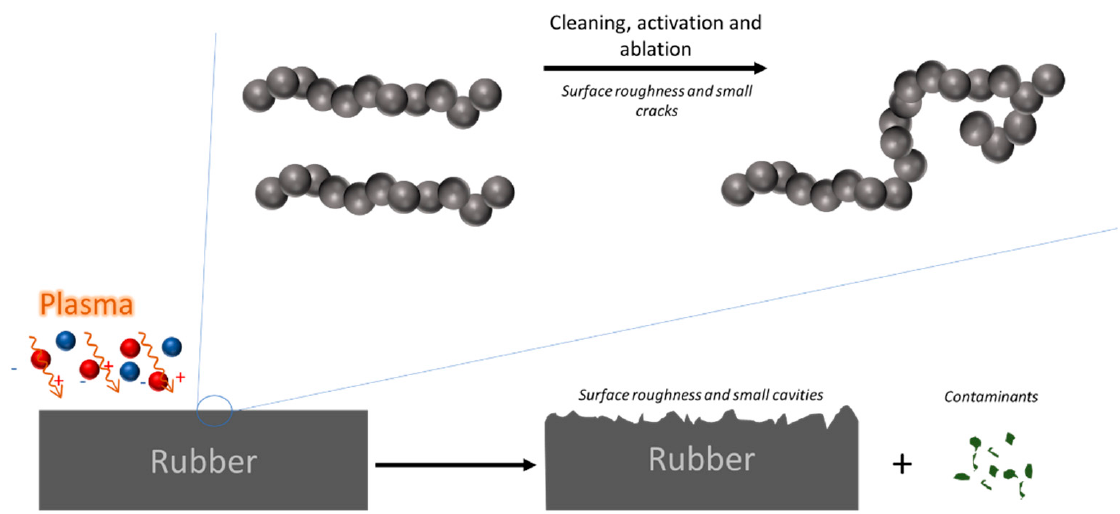
Figure 12. Simplified scheme of plasma effect on rubber surface.